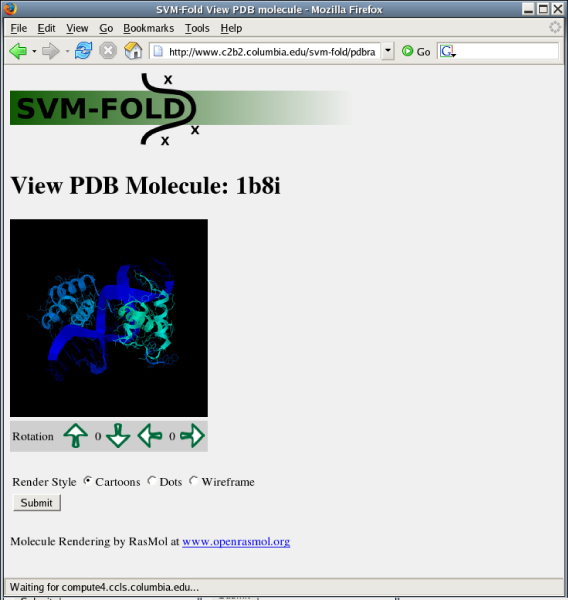
SVM-Fold molecule view. SVM-Fold provides links to views of representative 3D structures.